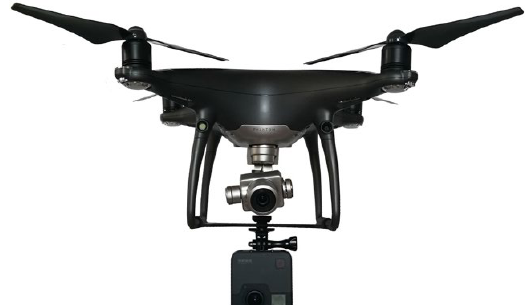
Figure 1. The UAVs/360° camera set up adopted in this research to perform a double sensor